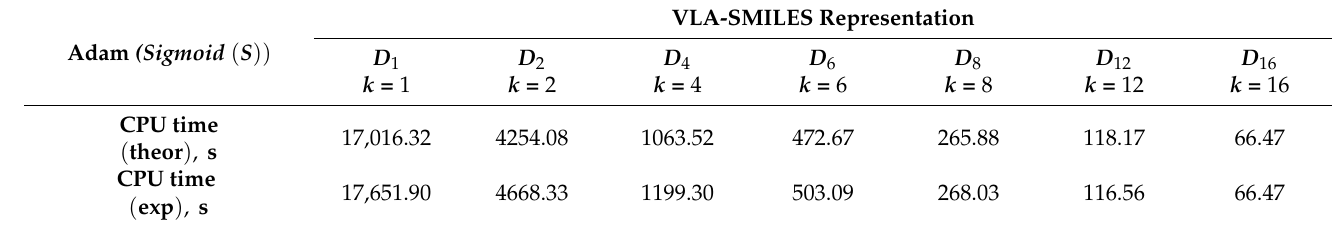
Table 2. CPU times for the training convergence of the models with VLA-SMILES representations (single-layer MLP with Adam learning, Kennard–Stone-based rational train–test splitting, and Sigmoid activation). The single prefactor in the theoretical CPU time was determined to reproduce the observed CPU for the MLP with D 16 ( k = 16) cluster-featured SMILES, Dataset#1.